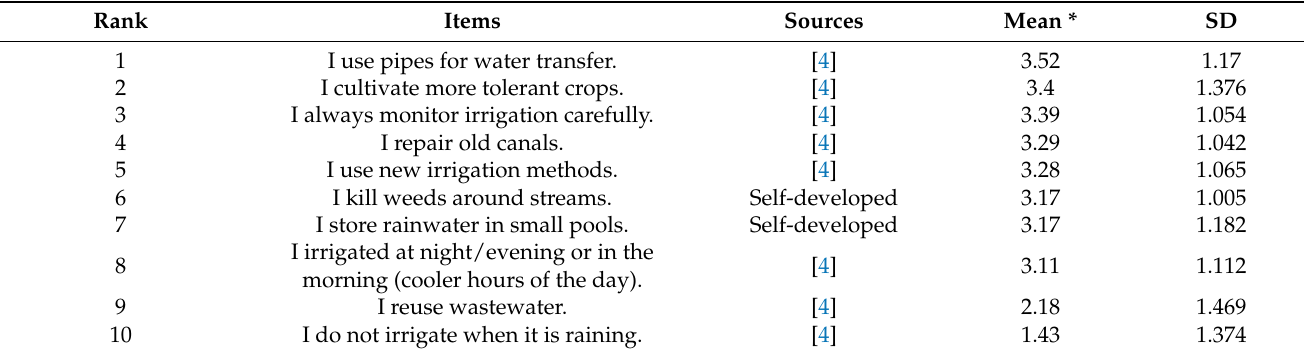
Table 3. The ranking of water protection behavior items.